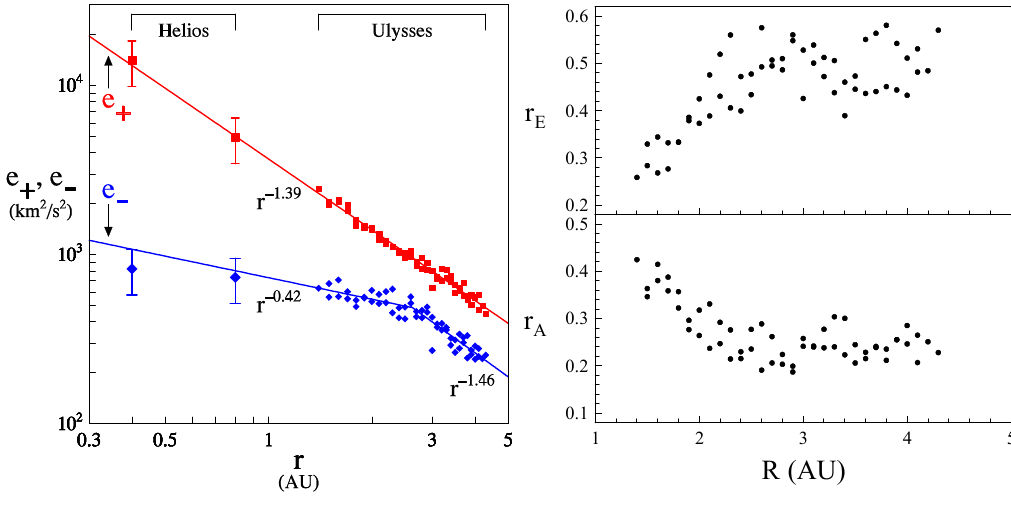
Figure 63: Left panel: values of hourly variance of 𝛿𝑧 ± (i.e., 𝑒 ± ) vs. heliocentric distance, as observed by Ulysses. Helios observations are shown for comparison and appear to be in good agreement. Right panel: Els¨asser ratio (top) and Alfv´en ratio (bottom) are plotted vs. radial distance while Ulysses is embedded in the polar wind. Image reproduced by permission from Bavassano et al. (2000a), copyright by